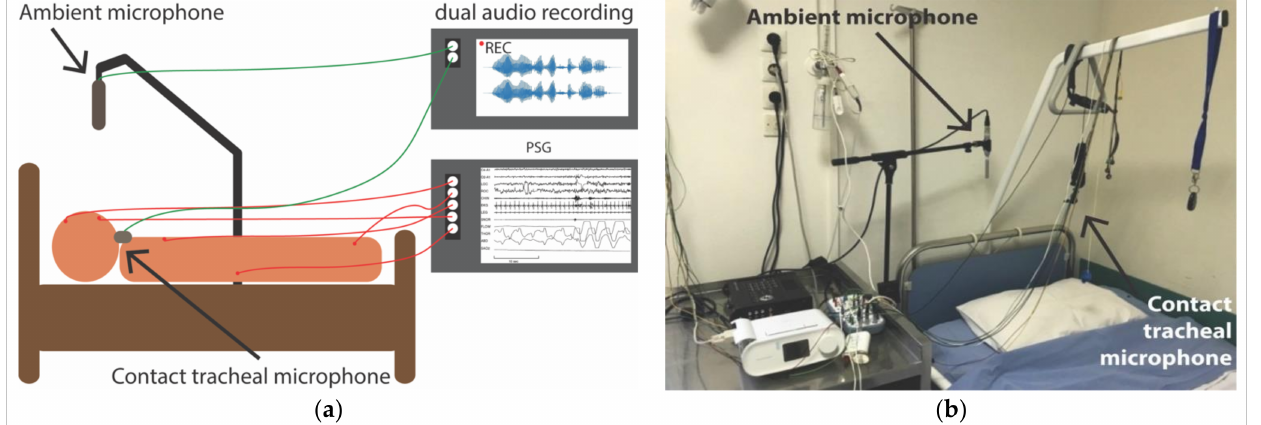
Figure 1. Setup of polysomnography records and dual audio recordings: ( a ) Schematic indicating the signals acquisition; ( b ) Photograph of the room of sleep study unit where the position of the ambient microphone can be